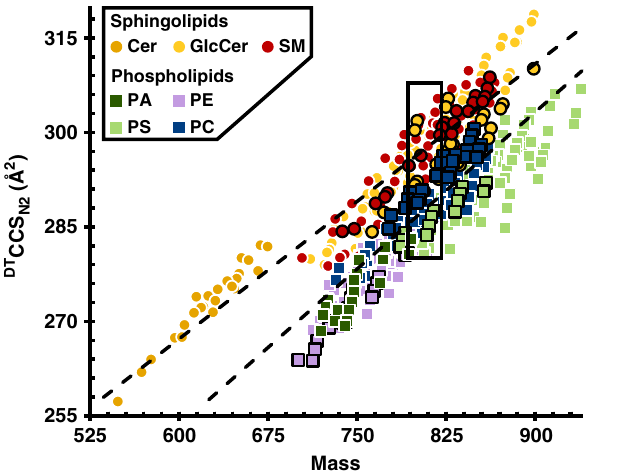
Fig. 2 Conformational space analysis of all 456 singly charged lipids surveyed in this work. Included are data from 7 classes from 2 lipid categories in positive and negative ionization mode. Markers for cations are indicated by a white border while those for anions are indicated by a black border. Error bars represent standard errors and are for each point within the scale of the marker. Speci fi c lipid identi fi cations, numerical measurement data, and number of measurements per data point ( n = 8 or 16 repeat measurements for positive ionization mode data, n = 20, 21, or 28 repeat measurements for negative ionization mode data) are provided in Supplementary Data [M + H-2H 2 O] + was observed in Cer and GlcCer. Whether water loss occurs in solution or during ionization is unknown.